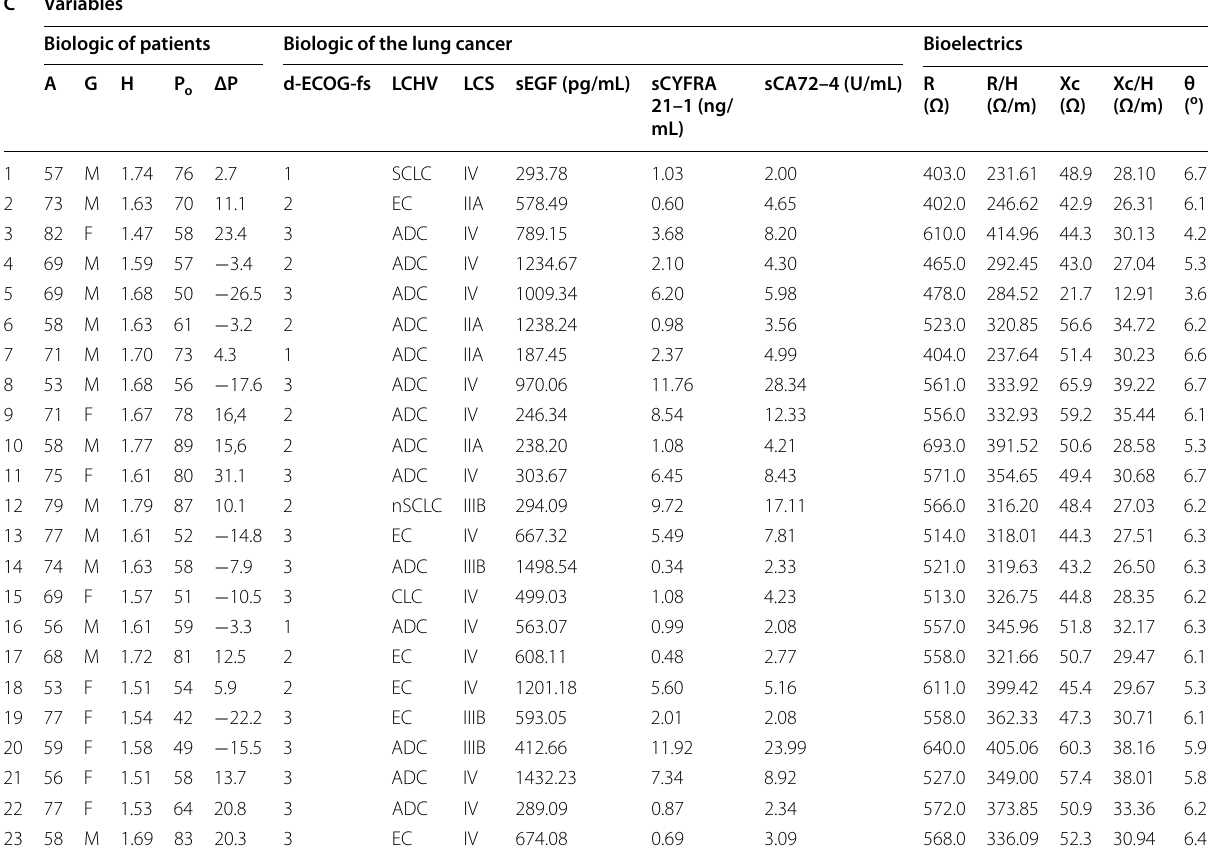
Table 1 Characteristic variables in each newly diagnosed lung cancer adult